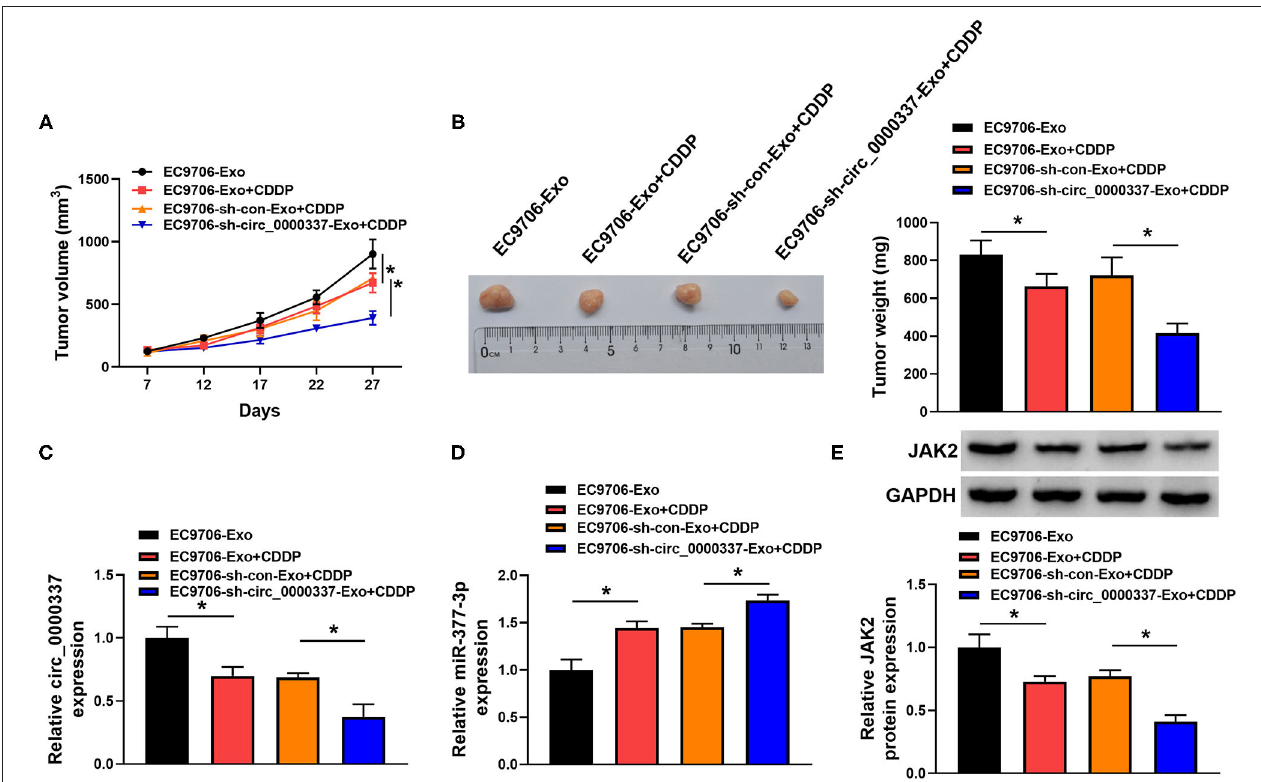
FIGURE 8 | Exosomal circ_0000337 facilitated tumor growth and CDDP resistance in vivo. (A,B) Tumor volume and tumor weight were detected in xenografts. (C,D) Expression of circ_0000337 and miR-377-3p was examined in xenografts by using RT-qPCR assay. (E) JAK2 protein level was determined in xenografts by using Western blot assay. * P <